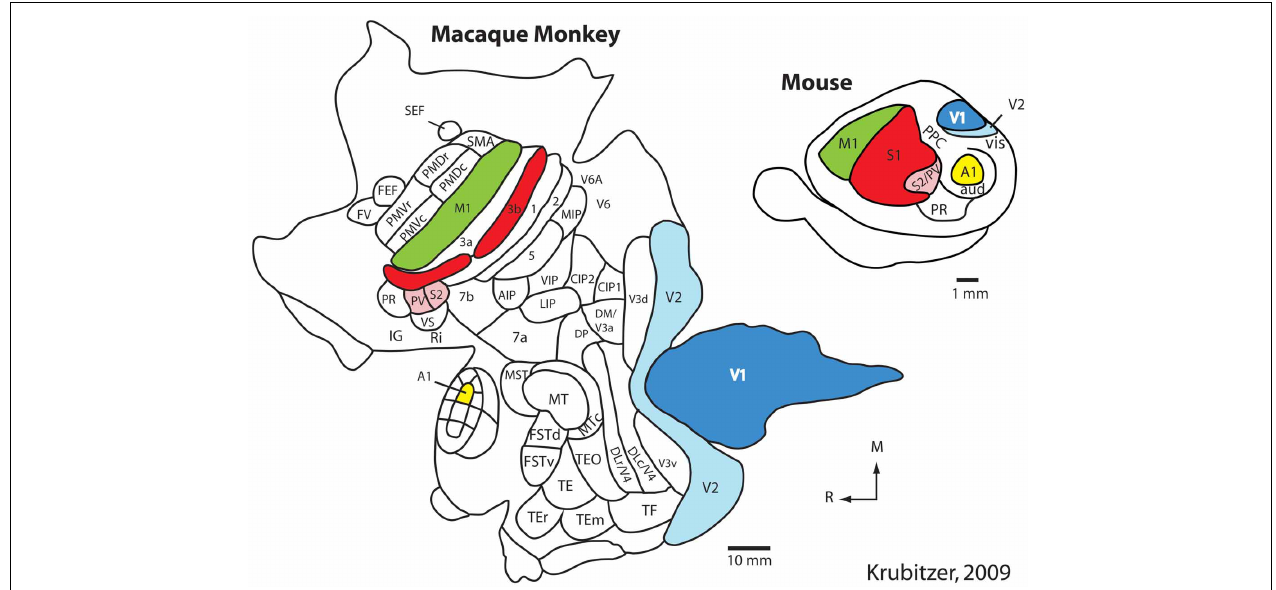
FIGURE 1 | The organization of the neocortex in the macaque monkey and mouse in cortex that has been peeled from the brainstem and thalamus and flattened. Homologous cortical fields include the primary somatosensory area (S1/3b; red), the second somatosensory area and the parietal ventral area (S2/PV; rose), the primary visual area (V1; dark blue), the second visual area (V2; light blue), the primary auditory area (A1; yellow) and motor cortex (M1; green). While this common plan of organization can be identified in these species, there are also notable differences. Specifically, in